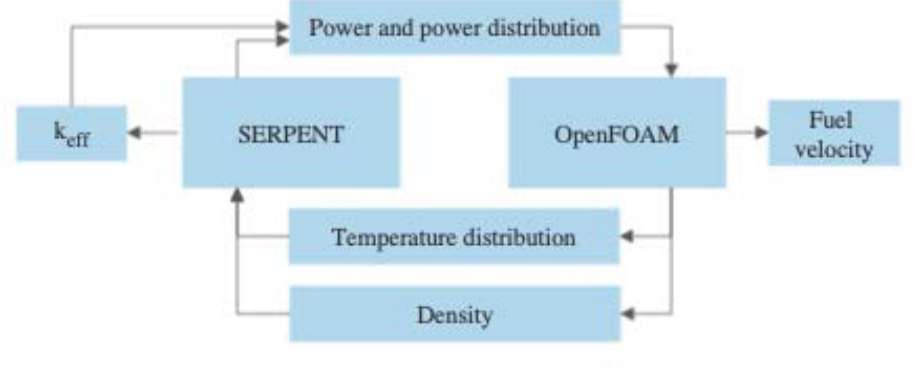
Figure 3.2 Schematic iteration scheme for SERPENT and OpenFOAM